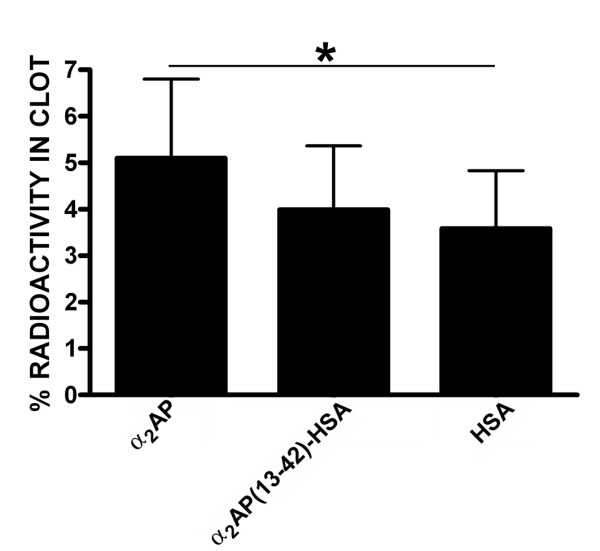
Localization of radiolabeled proteins in rabbit jugular vein clots in vivo. The radioactivity remaining in rabbit jugular vein clots allowed to polymerize in clamped-off vessels in situ for 30 minutes in the anesthetized animal, then to age with circulation restored for 60 minutes, prior to clot recovery and γ-counting is shown. Clots formed in the presence of 125I-fibrinogen and 131I-labelled plasma-derived α2AP or recombinant α2AP(13-42)-HSA or recombinant HSA. Individual data points are the mean of values for both left and right jugular veins, shown as the mean of 6 such means ± SD). Asterisk indicates the only comparison in the group significant (p < 0.05) by paired t-tests.